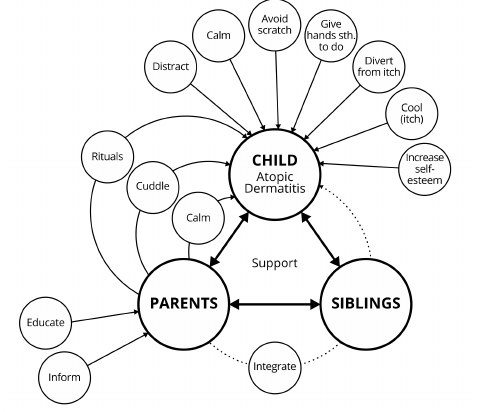
Figure 1. Results of the user-centered research: Perceived influencing factors of atopic dermatitis symptoms. The lines indicate that a positive e ff ect on children is seen by educating parents, especially when they are primary care